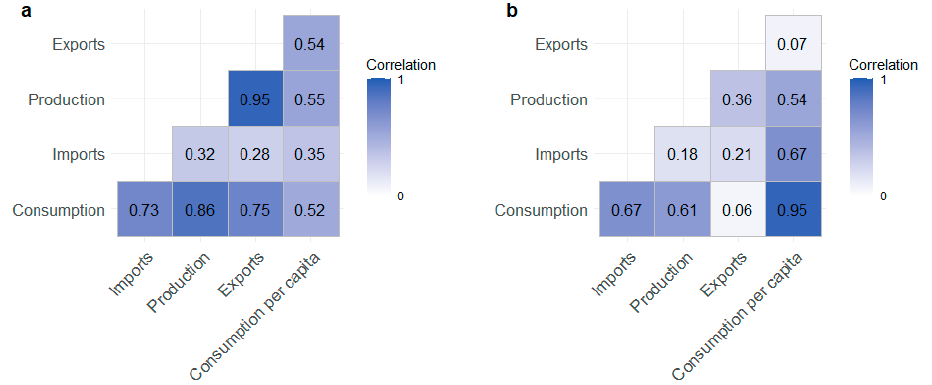
Figure 8. Correlation matrices exploring the relationships among the mean wine industry variables ( a ); and mean wine industry Z-scored variables ( b ).